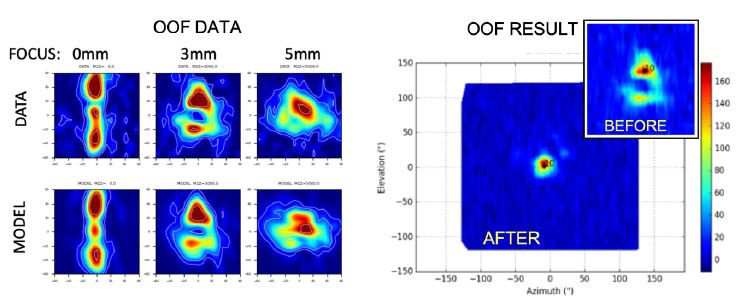
Figure 5. Example of OOF at the LMT during the daytime when surface deformations are significant. The panels on the left show the OOF data, consisting of beam maps at three positions of the secondary mirror. The upper row shows the actual data, and the lower row shows the OOF model fit. The right- hand panel shows the beam pattern after correction with the original beam shown in the inset